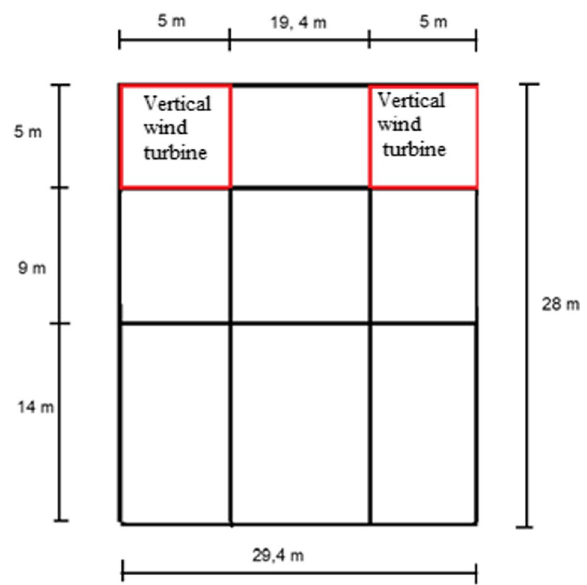
Fig. 15 Positioning scheme of 2 of the 4 large vertical wind turbines in the stern of the container